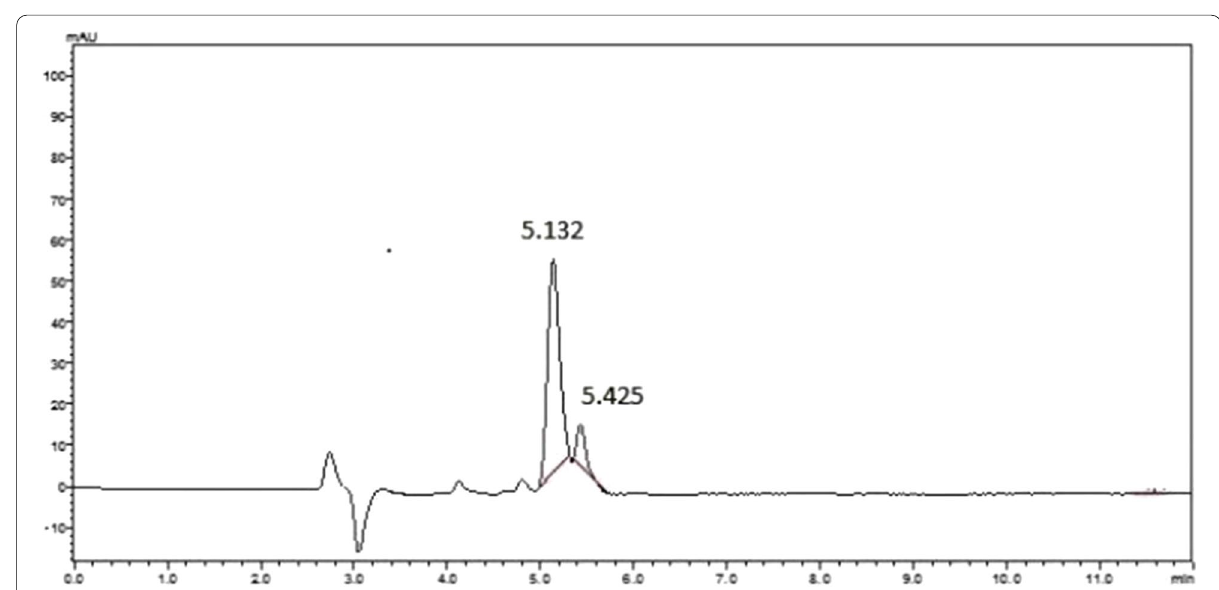
Fig. 7 Photodegradation in which Mupirocin calcium undergoes degradation under sunlight for 12